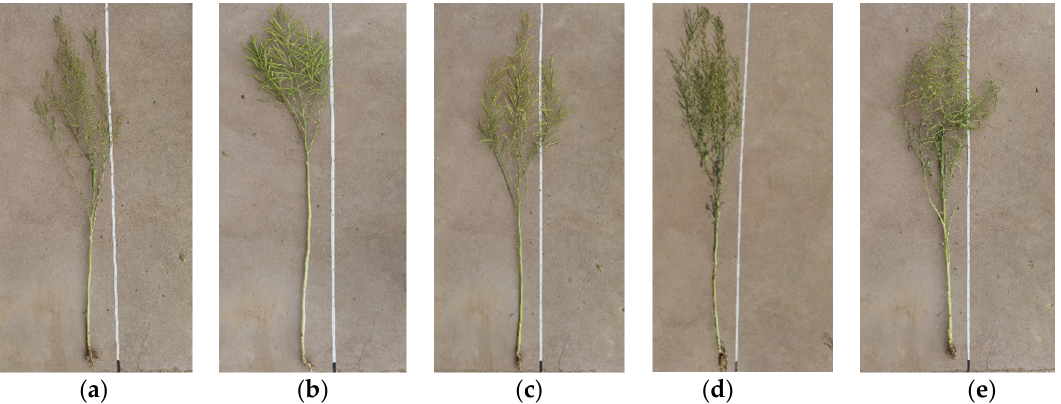
Figure 4. The measured OSR plants; ( a ) OSR plant from the UAAS pollination area; ( b ) OSR plant from the NW+UAAS pollination area; ( c ) OSR plant from the HB pollination area; ( d ) OSR plant from the NP pollination area; ( e ) OSR plant from the NW pollination area.